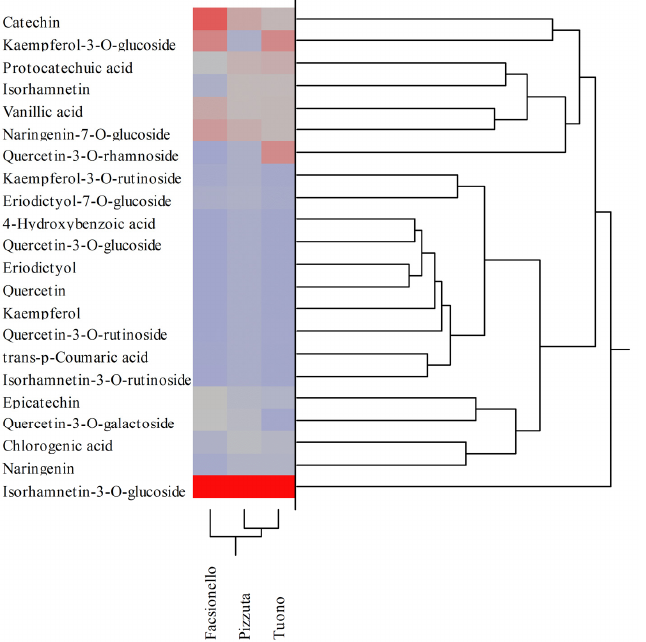
Figure 3. Agglomerative two-way hierarchical clustering analyses of the polyphenolic profiles of blanched skin extracts (BSE) belonging to Fascionello, Pizzuta, and Tuono cultivars.